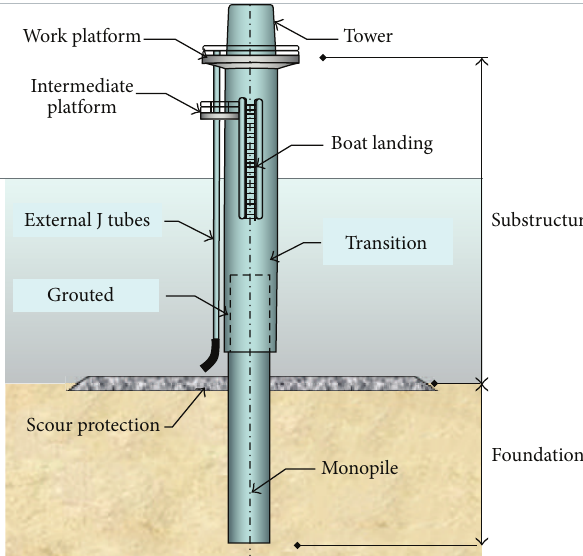
Figure 1: Monopole foundation, consisting of a driven pile [3].